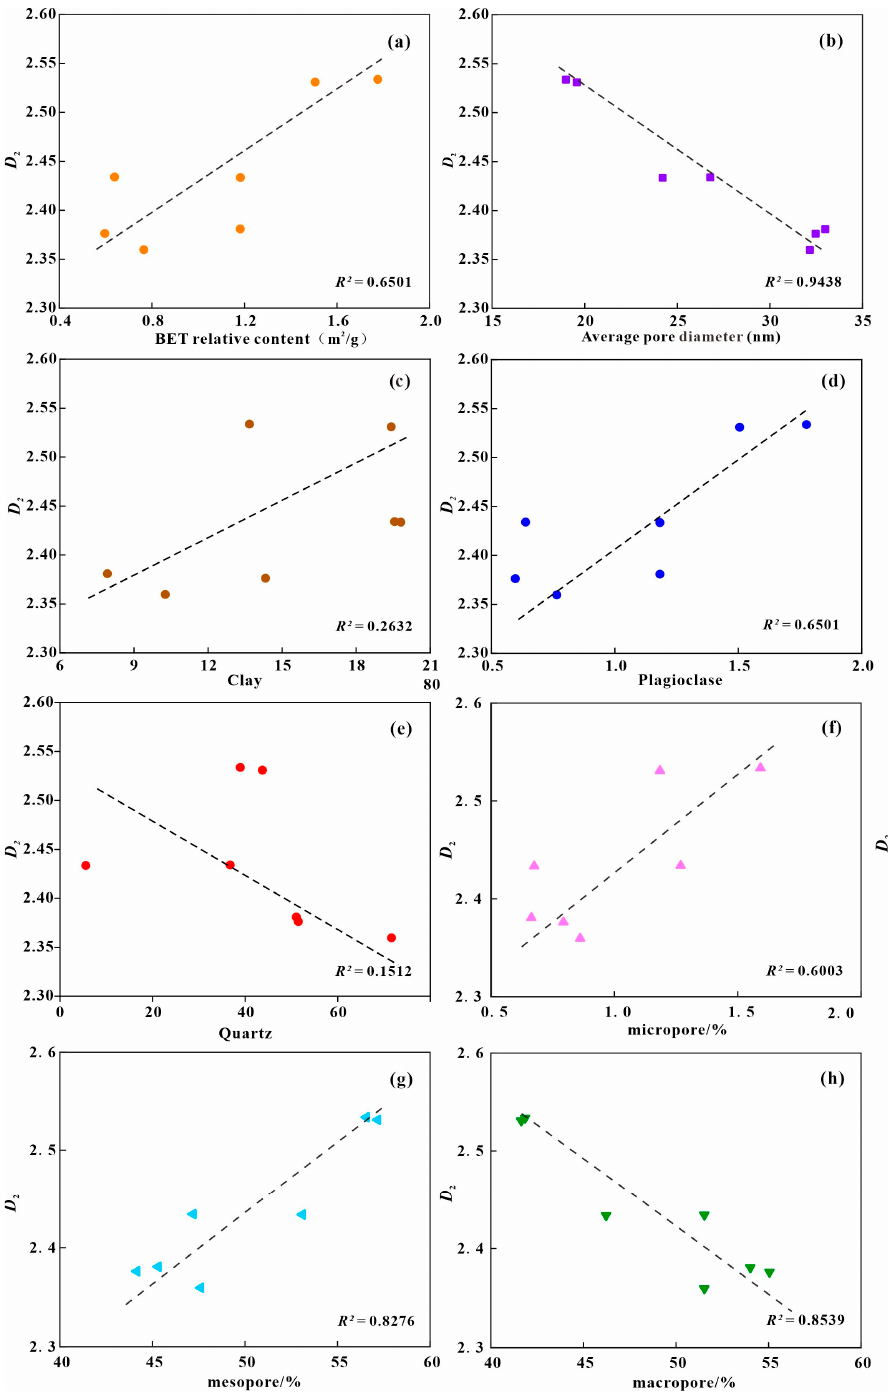
Figure 10. Influencing factors of single-fractal dimension: ( a ) Relationship between D 2 and SSA. ( b ) Relationship between D 2 and d a . ( c ) Relationship between D 2 and clay content. ( d ) Relationship between D 2 and plagioclase content. ( e ) Relationship between D 2 and quartz content. ( f ) Relationship between D 2 and micropore volume. ( g ) Relationship between D 2 and mesopore volume. ( h ) Relationship between D 2 and macropore volume.